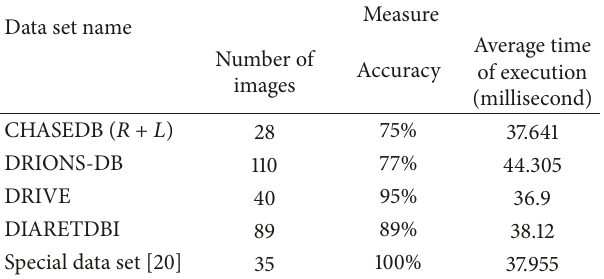
Table 1: Comparison of the results for different data sets.